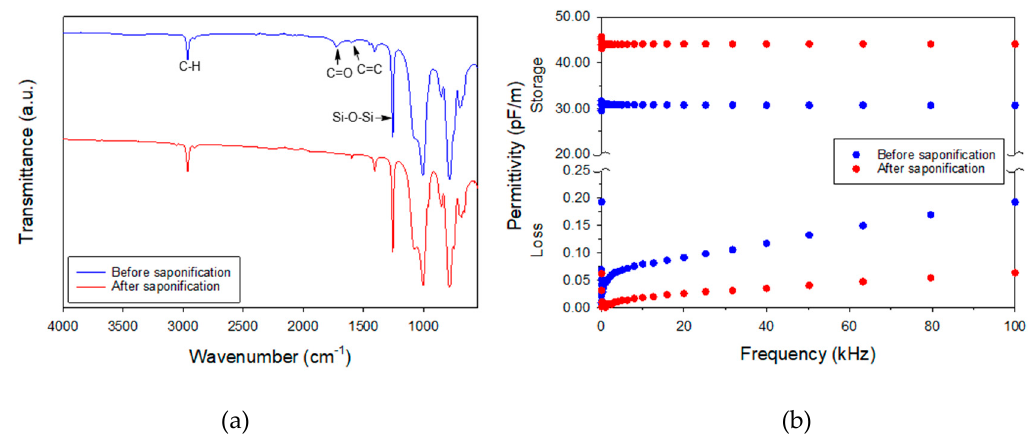
Figure 2. IR spectra of the UV-cured film fabricated from the V30 solution layer ( a ) and dielectric permittivity of the film from the V10 solution layer ( b ) before and after saponification.